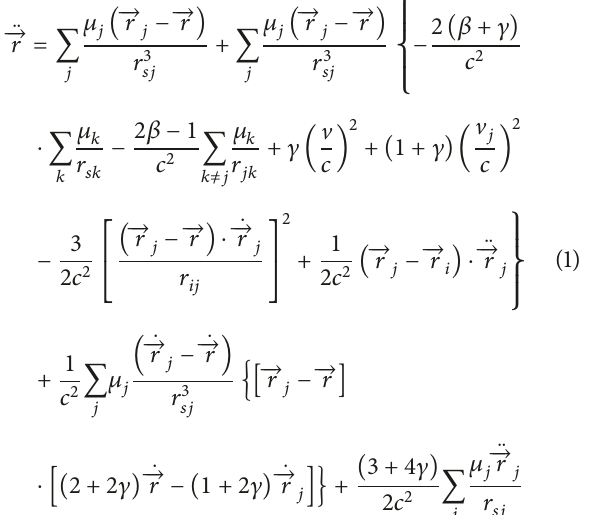
Figure 3: The flowchart of the Mars ephemeris